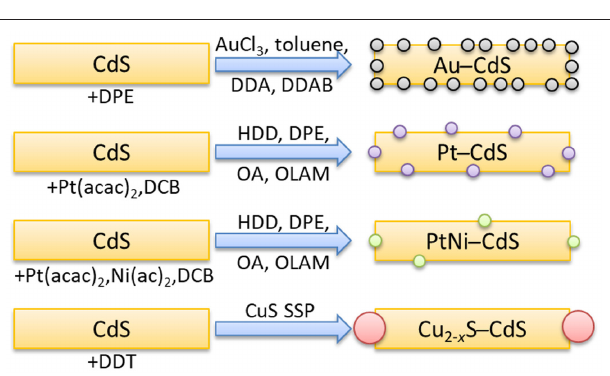
FIGURE 1 | TEM images of (A) CdS NPLs, (B) CdS–Au, (C) CdS–Pt, and (D) CdS–PtNi HNSs. All scale bars are 50nm.